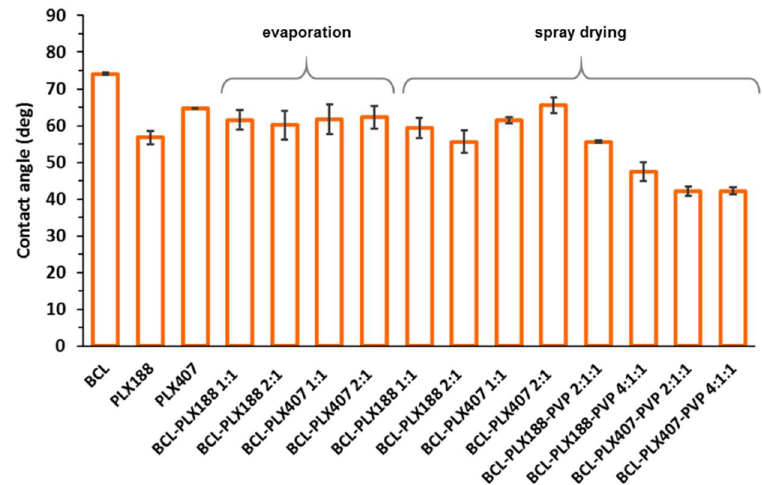
Figure 9. The values of contact angles of raw bicalutamide and poloxamers, binary and ternary systems containing bicalutamide, poloxamers, and PVP obtained using either evaporation method or spray drying.